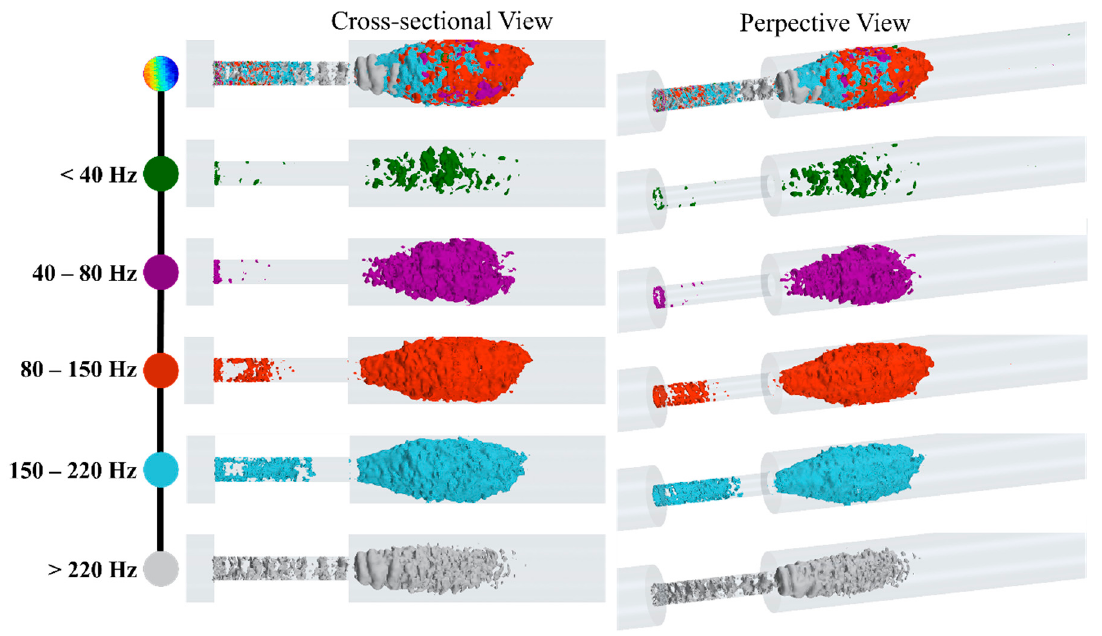
Figure 13. Snapshots of high-energy fluctuations are shown with isosurfaces of the RMS of acoustic pressure for different bandwidths.